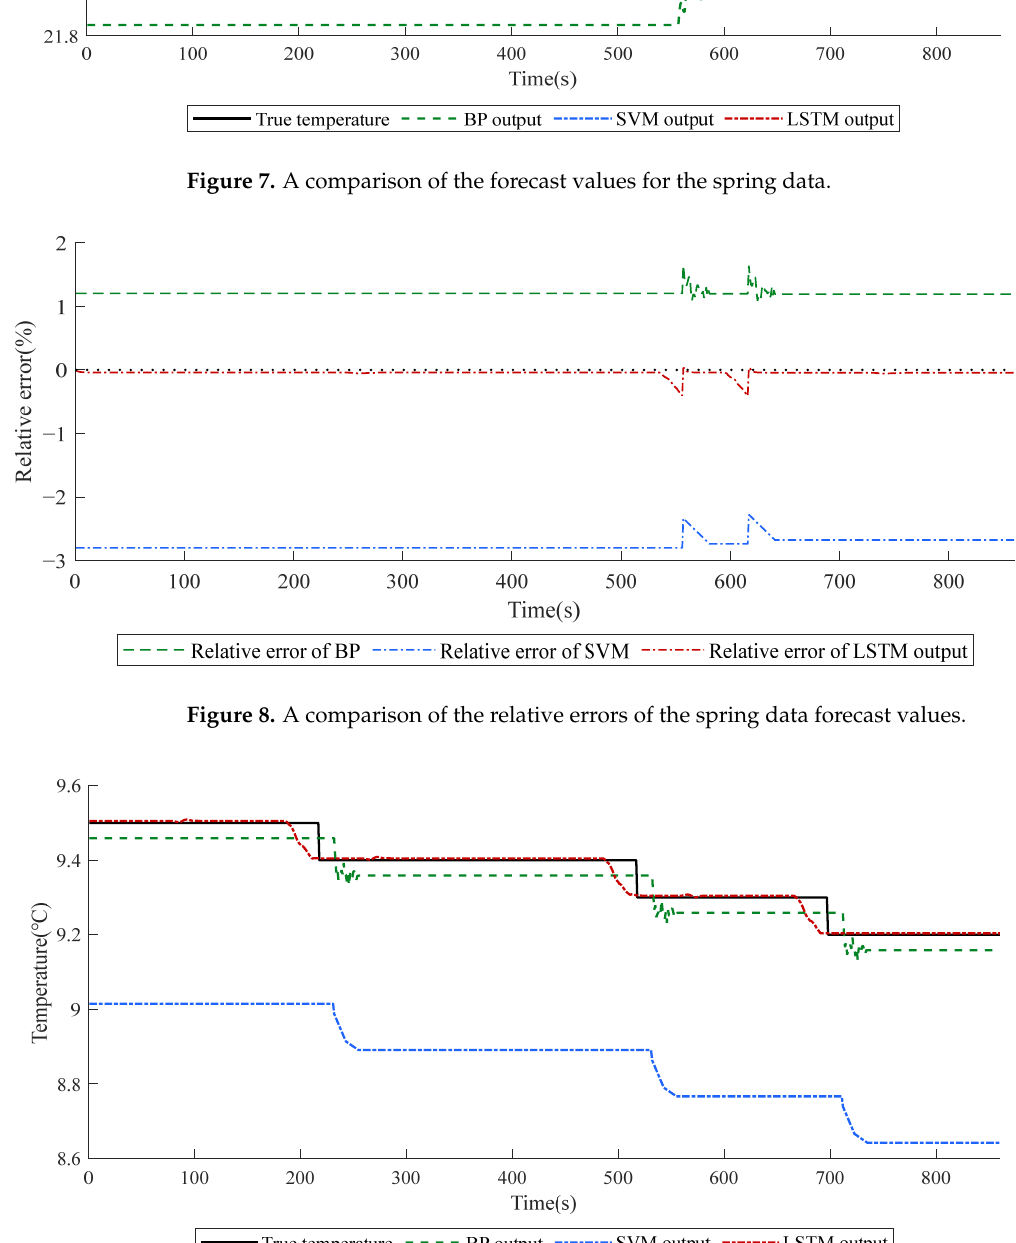
Figure 9. A comparison of the forecast values for the winter data.